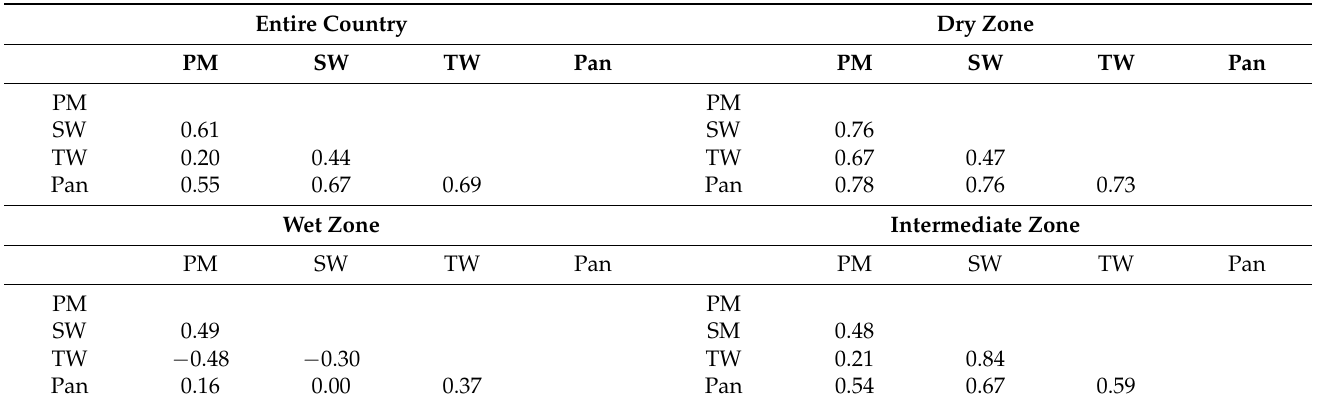
Table 5. Pearson correlation coefficients among four PET methods in different regions: entire county, Pan, pan